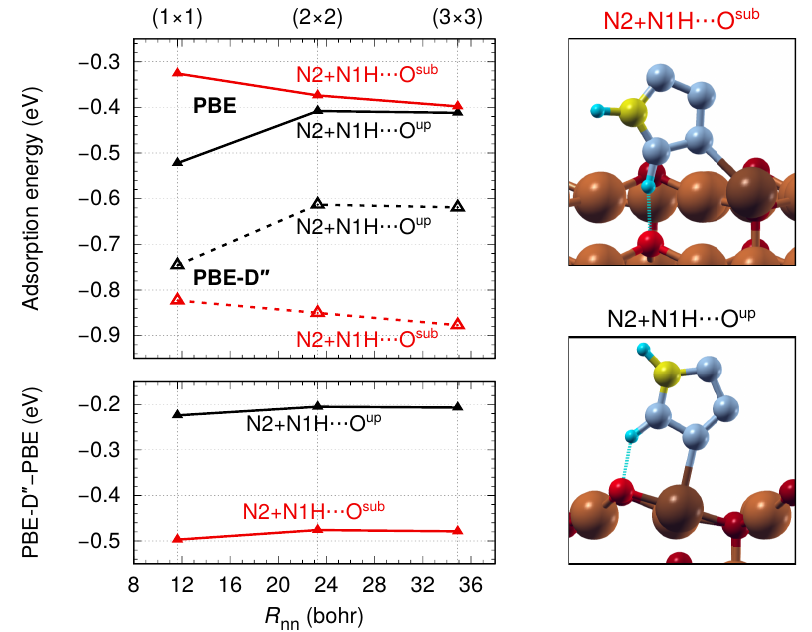
Figure A3. Top-left : PBE and PBE-D (cid:48)(cid:48) calculated average adsorption energy as a function of the nearest-neighbor intermolecular distance ( R nn ) for two different adsorption structures of tetrazole on Cu 2 O(111)-w/o-Cu CUS . Notice that PBE predicts the N2+N1H · · · O up ( black ) and PBE-D (cid:48)(cid:48) the N2+N1H · · · O sub ( red ) structure to be the most stable; snapshots of the two are shown on the right . Bottom-left : the difference between PBE-D (cid:48)(cid:48) and PBE adsorption energies for the two